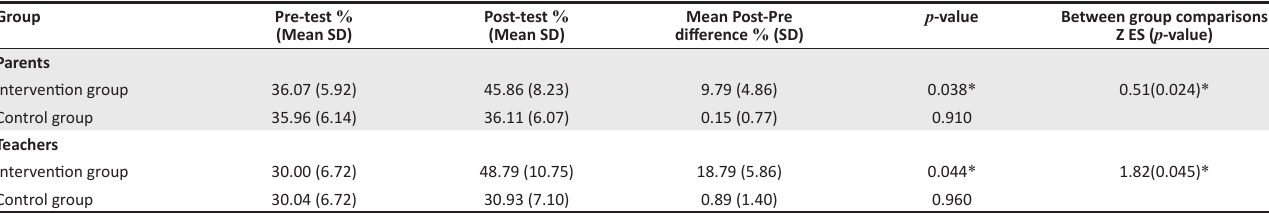
TABLE 5: DCDQ scores pre-and post-intervention.